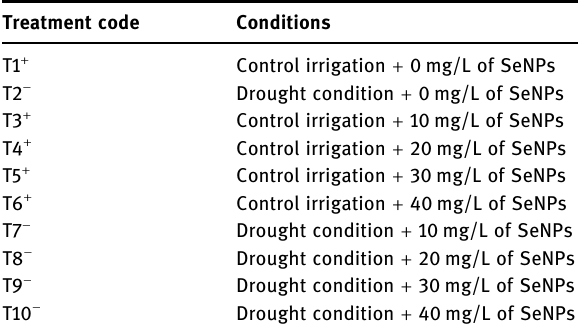
Table 1: The layout of the treatments of the wheat plants